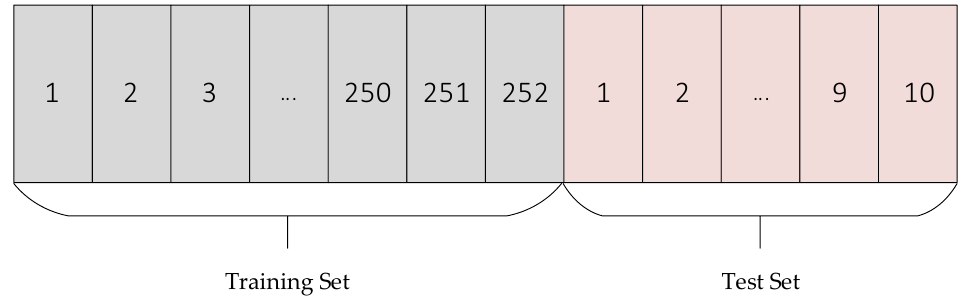
Figure 2. Comparison of SSE index results of algorithm optimization search.